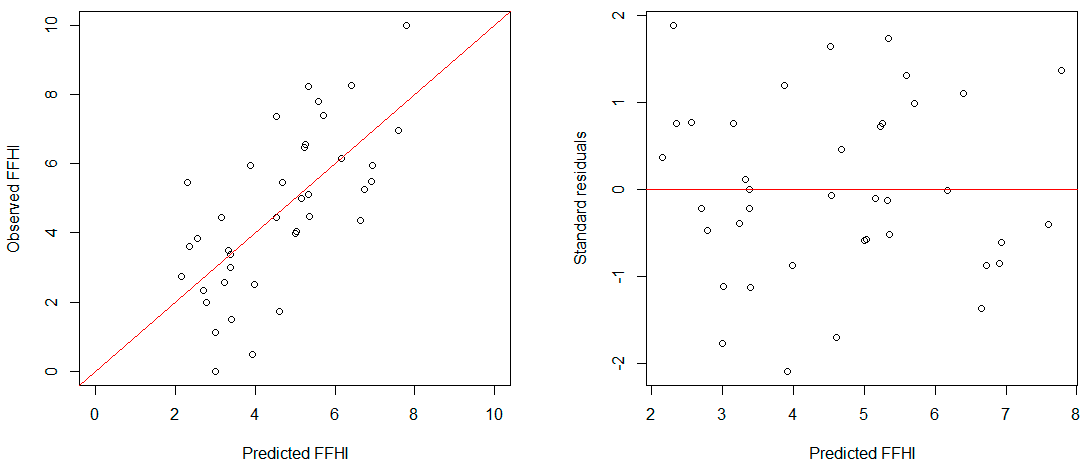
Figure 3. Plot of predicted FFHI against observed FFHI and the residual plot.